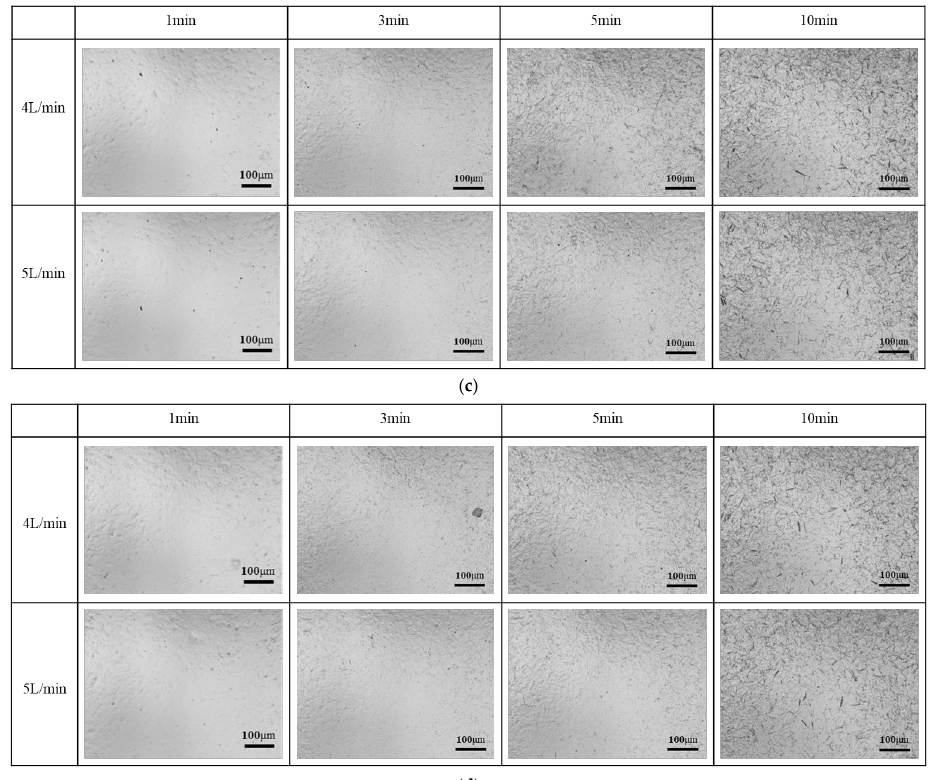
Figure 10. Surface damage at various points under the experimental conditions of different gas-flow rates. ( a ) Surface damage at point 1 with different gas-flow rates, ( b ) Surface damage at point 3 with different gas-flow rates, ( c ) Surface damage at point 7 with different gas-flow rate, ( d ) Surface damage at point 10 with different gas-flow rate. Meanwhile, we also measured the surface roughness R Z of the specimen from images and compared the surface roughness R Z of the specimen under the two different condi- tions. The change in surface roughness R Z as a function of exposure time in the bubbling condition with different air-flow rates are shown in Figure 11. It was confirmed that the surface roughness R Z at the 5 L/min air-flow rate was slightly smaller than that at the 4 L/min air-flow rate when the test time was 5 min. In addition, it was also seen that there was little difference in surface roughness R Z at 4 and 5 L/min air-flow rate when the test time were 3 and 10 min.